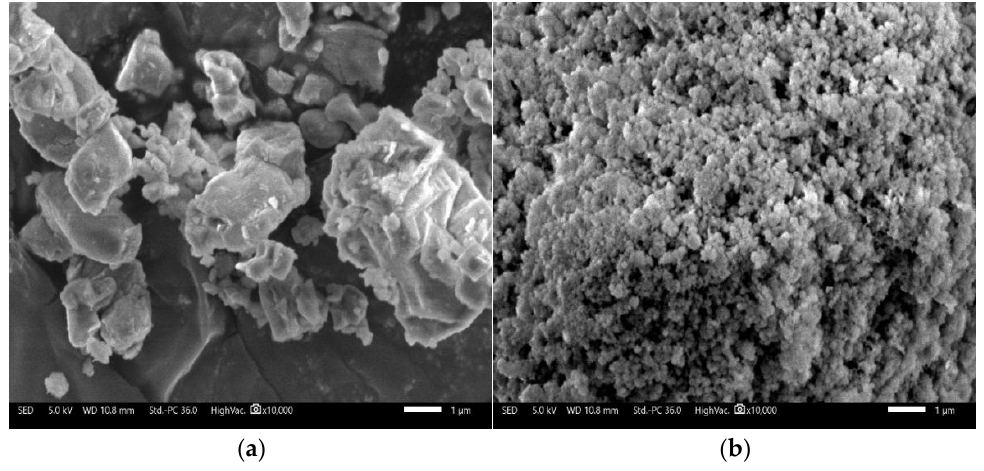
Figure 2. SEM images of calcium oxide ( a ) and silica fume ( b ).